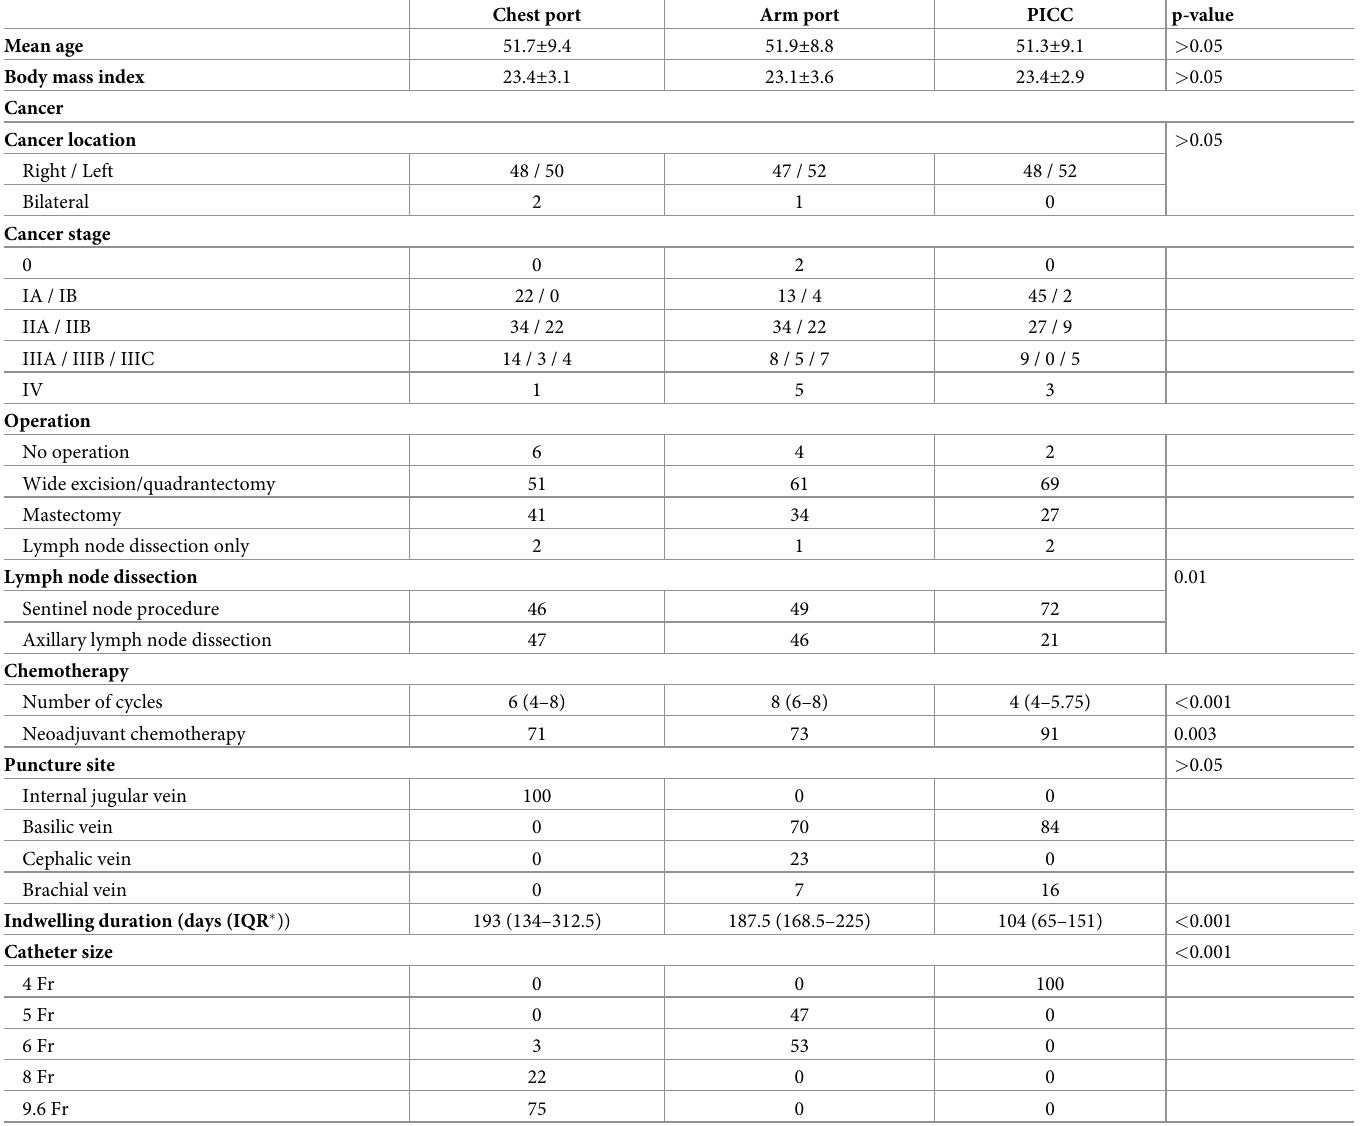
Table 1. Baseline demographic